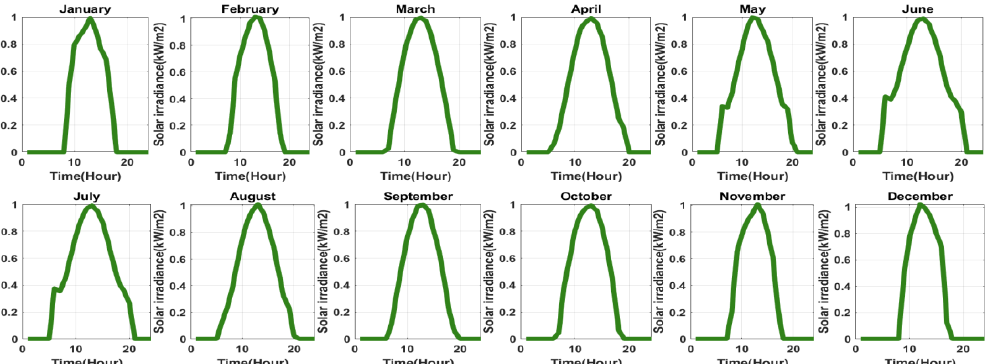
Figure 8. Solar irradiance.